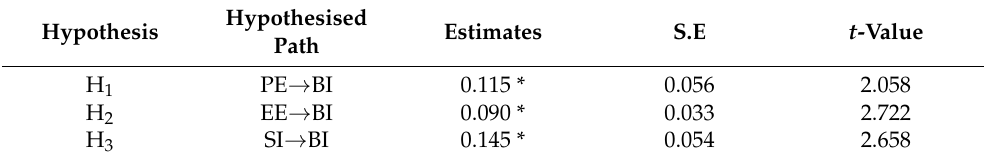
Table 4. Relationship of students’ behavioural intention to use smart technologies in blended